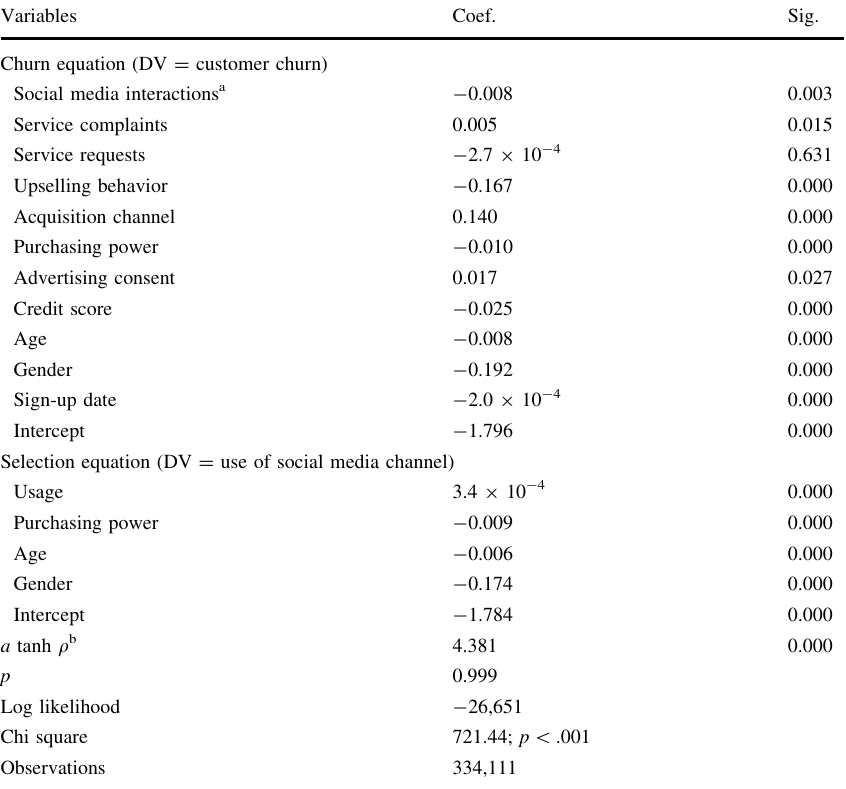
Table 4 Influences on customer churn